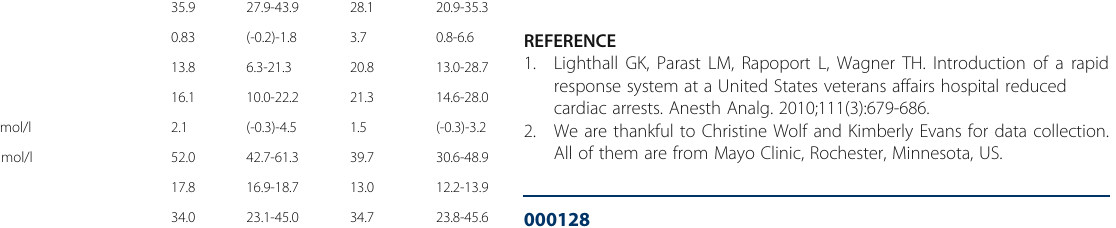
Table 1 (abstract 000212). Mean percentage of days of specific events occurring out of total possible days (%), 95% Confidence Intervals (CI); INT: Intermittent; CONT: Continuous; GRV: Gastric residual volume; CGV: Coefficient Glucose Variation; *p<0.001 Mean percent daily events,%;